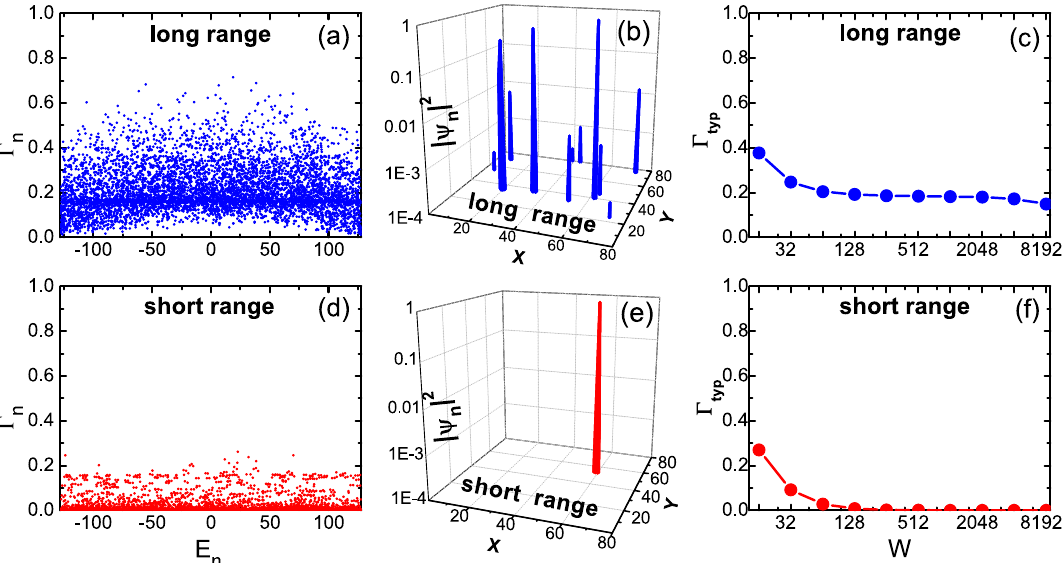
Figure 5. (Color online) Eigenstates of a 80 × 80 sample for the long range model γ = 0.5 (upper row) and the short range model γ = 0 (lower row). Left column: the fractal dimension Ŵ n versus eigenenergy E n , with the disorder strength W = 256 . Middle column: the spatial distribution of the squared magnitude of an eigenstate | ψ n | 2 with Ŵ n ∼ Ŵ typ . Right column: Ŵ typ as a function of the disorder strength W (logarithm